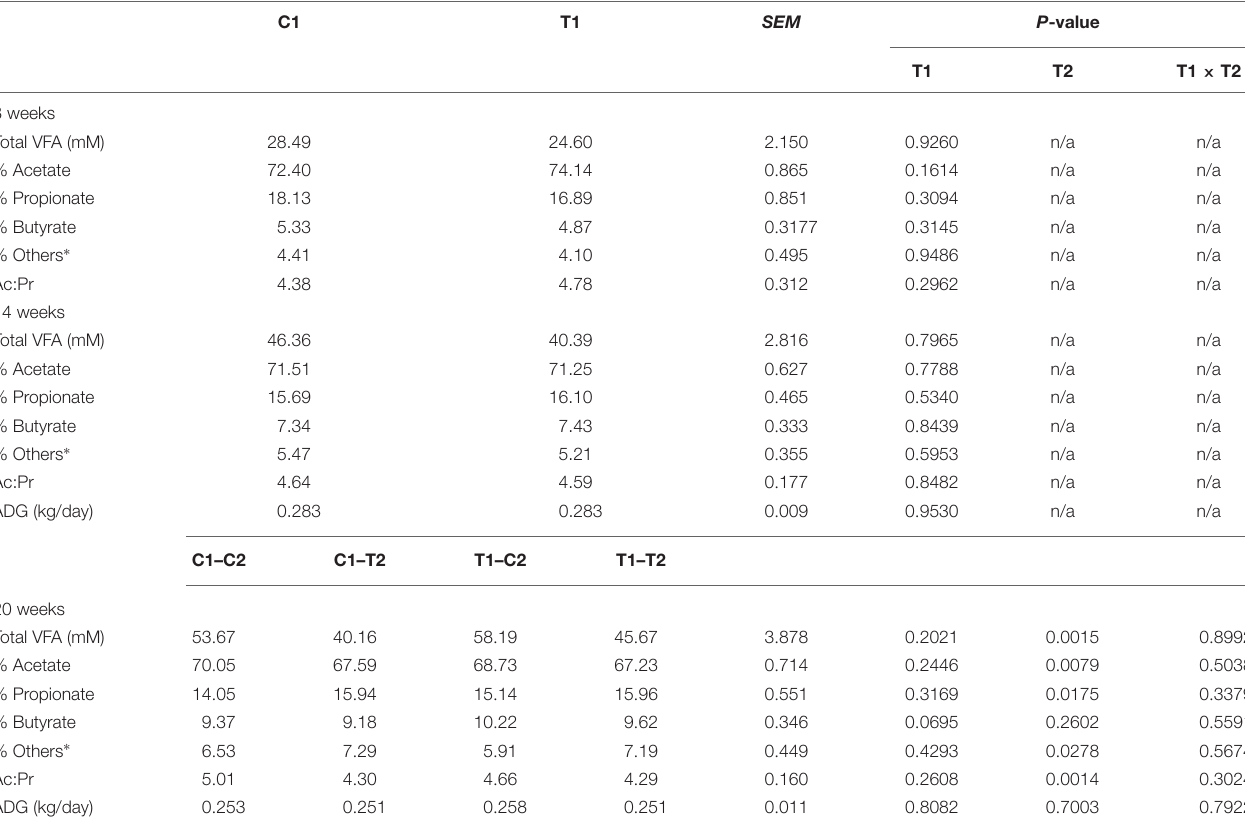
TABLE 2 | Values of total volatile fatty acids (VFA) concentration, proportions of acetate, propionate, butyrate and other VFA, acetate to propionate ratio in the rumen and average daily gain of control lambs (C1) and lambs treated with a linseed-garlic combination (T1) from birth up to 10 weeks of age.